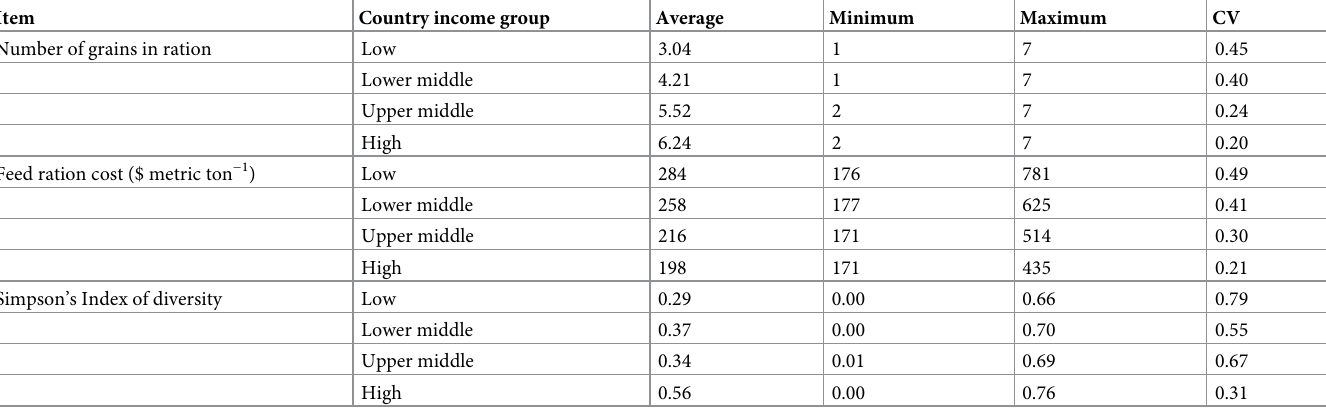
Table 4. Summary, non-inferential, statistics for cereal grain feed rations using reference ration